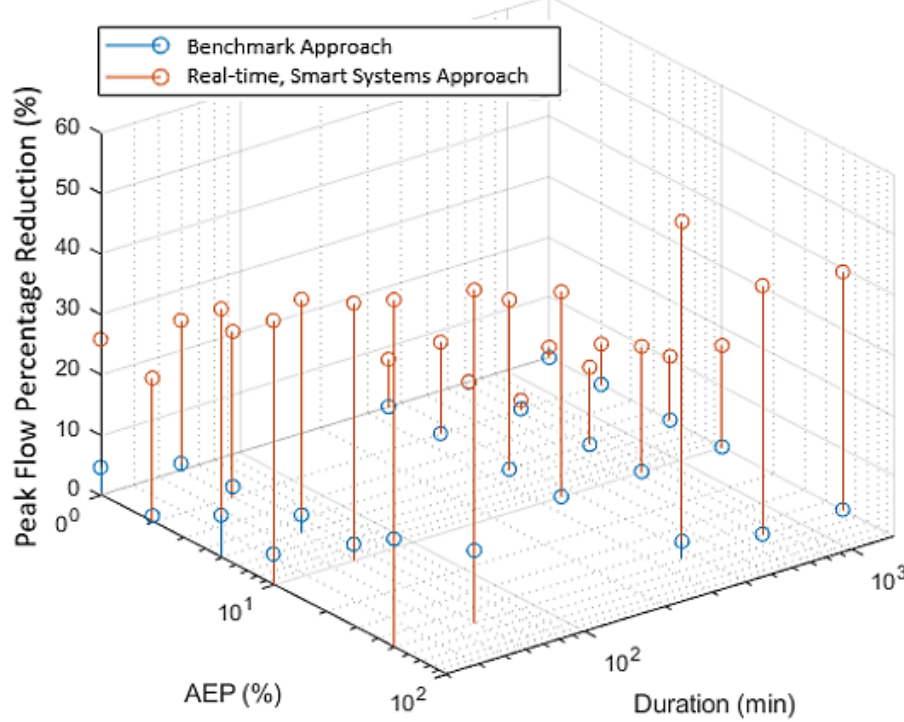
Figure A5. Percentage peak flow reduction of benchmark tanks and real-time, smart tank systems for a range of durations and AEPs with 2 × 2 m 3 tanks in Sydney.